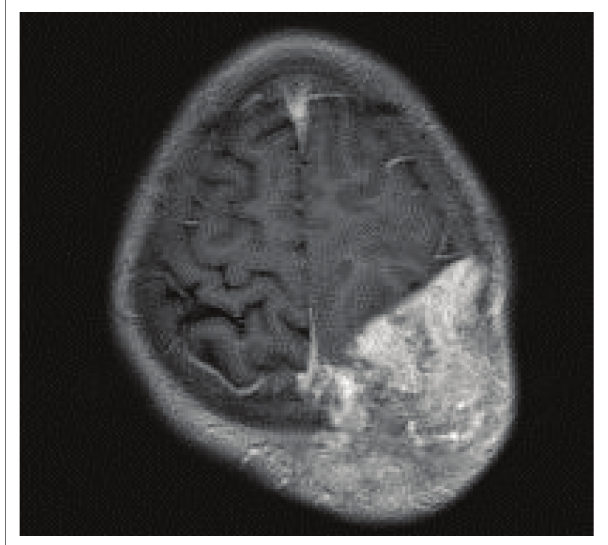
FIGURE 5: Contrast enhanced T1-weighted axial MR image showing intense heterogenous enhancement of the mass lesion.